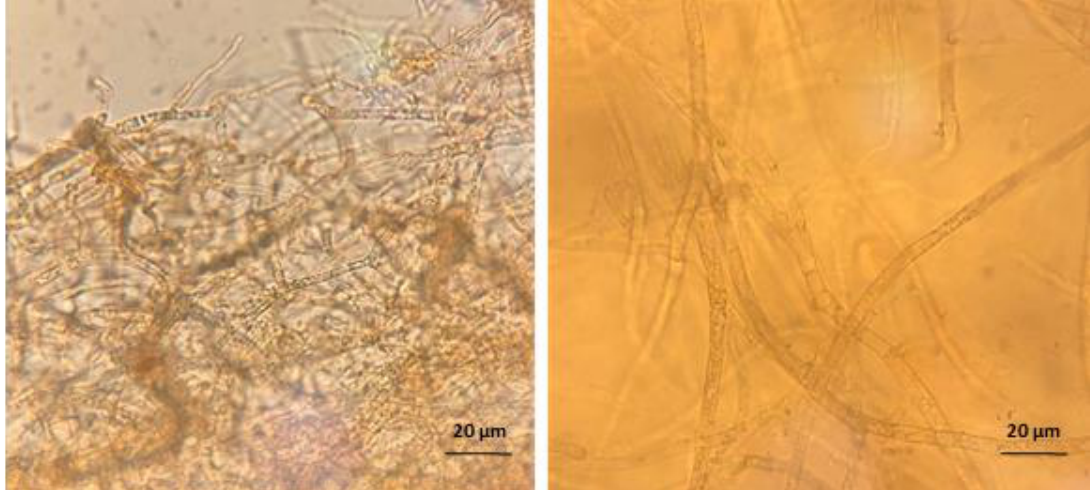
Figure 6. Microscopic images at 10× magnification showing hyphal width: qualitative comparison of biofilm grown on plastic ( left ) and biofilm grown on fibrin ( right ).